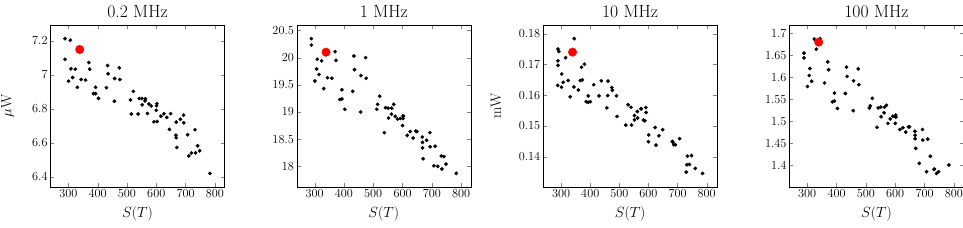
Figure 10: Post-routing power measurements of several Trivium ( X, 3) circuits as a function of S ( T ) for using the TSMC 90 nm process. The red data points signify the power consumption of the original Trivium . Note that fewer data points are being plotted as the post-routing workflow is significantly more time consuming in comparison to post-synthesis